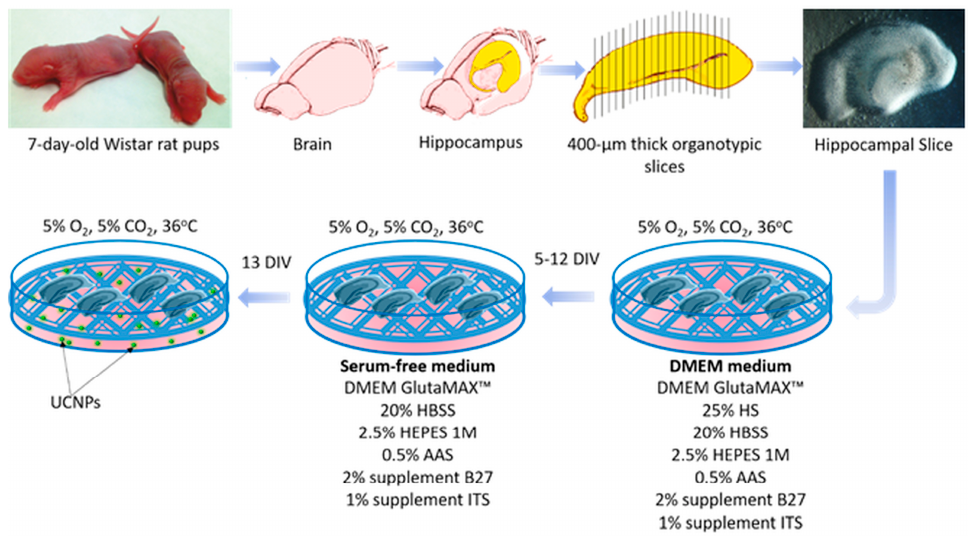
Figure 8. Schematic representation of the experimental